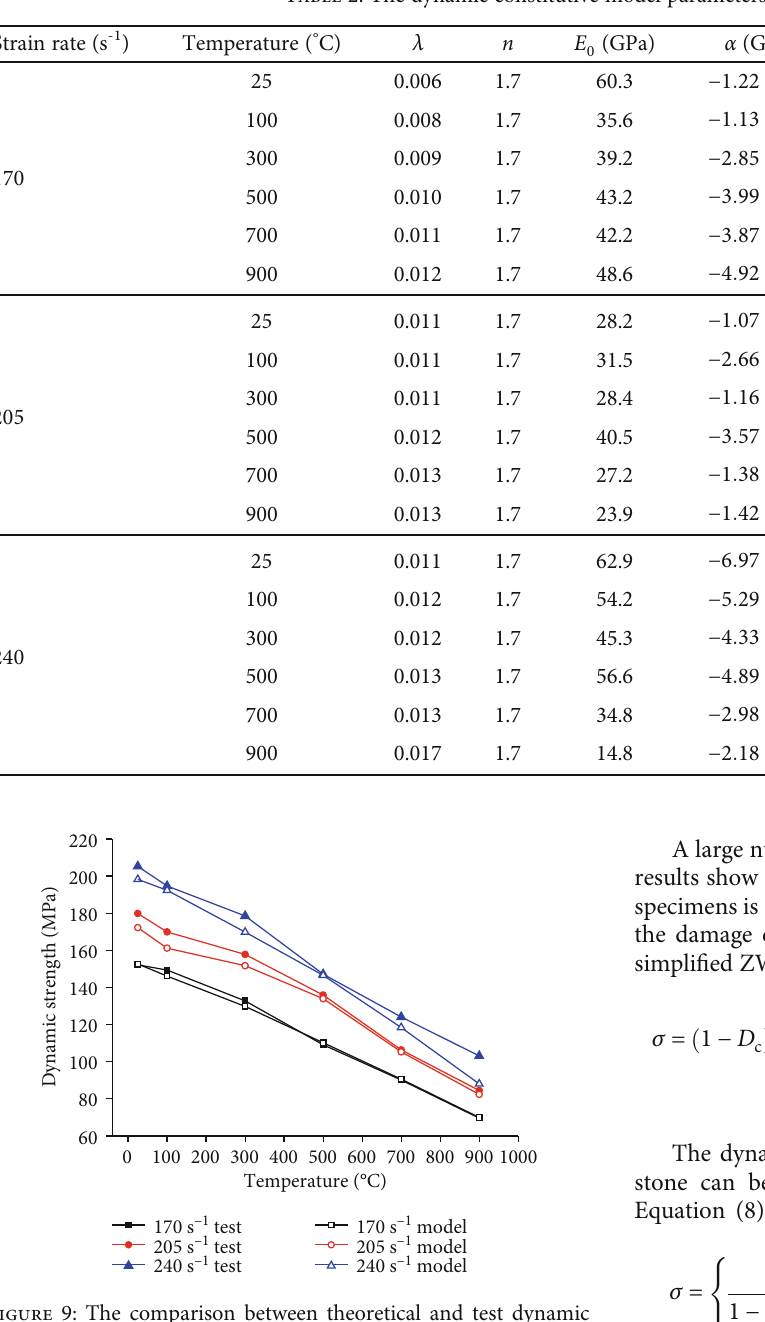
Table 2: The dynamic constitutive model parameters of deep sandstone.